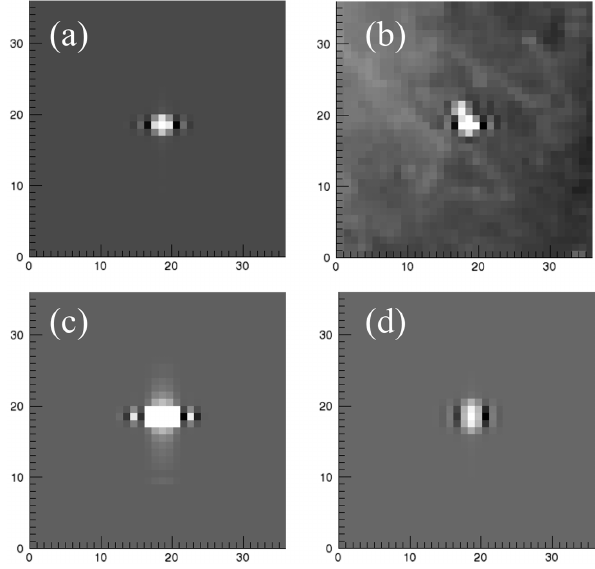
Figure 6. Simulated SEVIRI IR3.9 (MWIR) imagery of active fires, shown in comparison to real imagery. Images are scaled with the highest brightness temperature in the images shown as white and the lowest as black. The x and y axes are in SEVIRI image column and row coordinates. (a) is a simulated MWIR view of a 350MW fire contained within the ground area of a single SEVIRI 3km pixel and with the convolved filter shown in Fig. 7 applied. The fire signal appears smeared across many pixels, and the result appears sim- ilar to typical SEVIRI imagery of active fires shown in (b) but noting that the dominantly along-scan nature of the smearing may not be so apparent in real SEVIRI imagery due to the pixel geolo- cation processes performed during the level 1.0 to level 1.5 pre- processing procedures. (c) and (d) show simulation of larger fires stretching across three 350MW SEVIRI pixels in the E–W and N– S directions, respectively, with the impact of the filtering shown to be dependent upon the fire orientation with respect to the SEVIRI scan process. The simulations are indicative only, with a uniform surface temperature, atmospheric transmission, and emissivity as- sumed, and the sub-pixel fire of fixed FRP located at the scene cen-